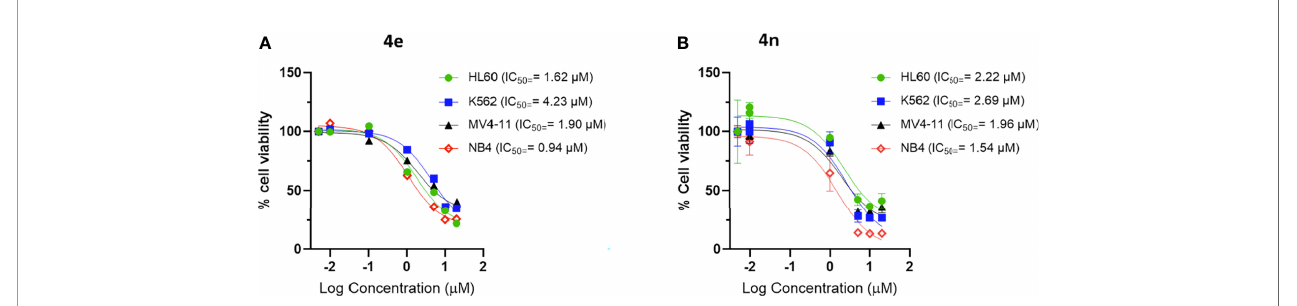
FIGURE 2 | Dose response curve of (A) 4e and (B) 4n on leukemia cell lines. Cells were incubated with increasing concentration of compounds for 48 h and viability was assessed using CellTiter ® -Blue Cell Viability Assay